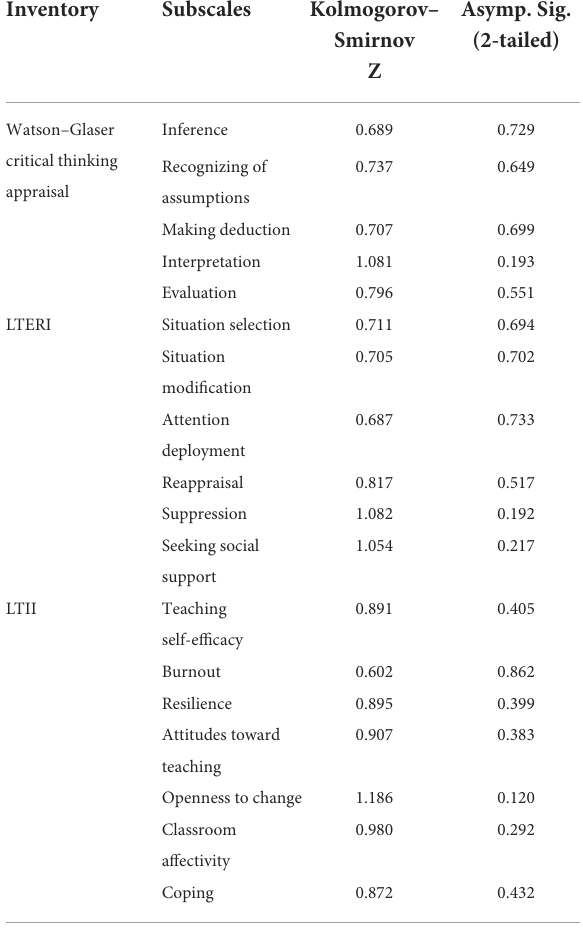
TABLE 2 The results of kolmogorov–smirnov test. TABLE 3 The results of fit indices (model